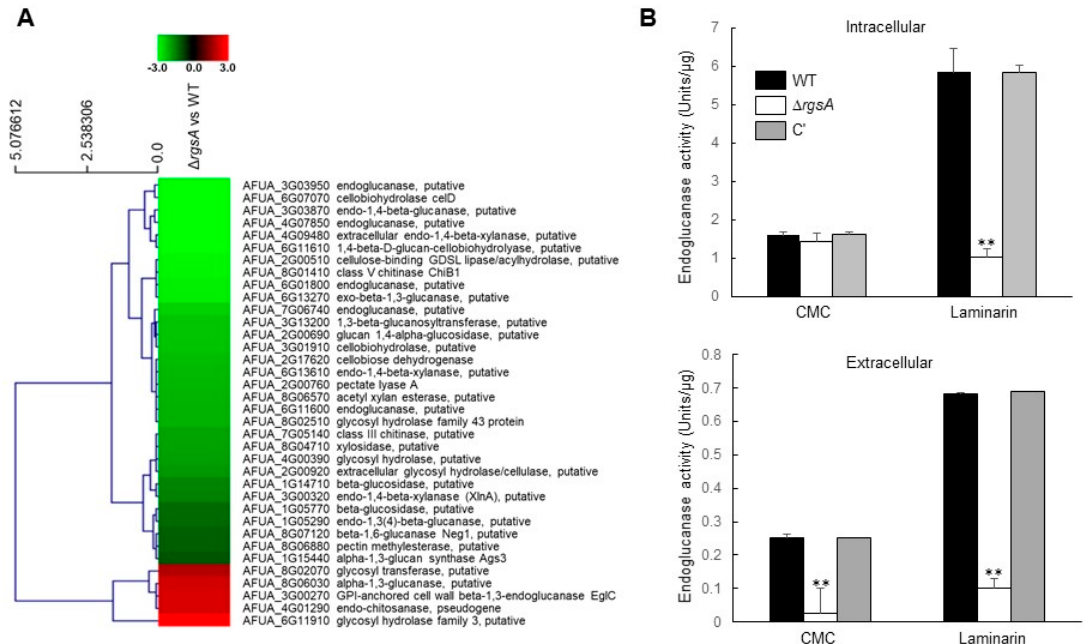
Figure 6. RgsA is needed for proper carbohydrate metabolism. ( A ) Heat map of those genes encoding carbohydrate-metabolism related enzymes. Most of genes were down-regulated by the lack of rgsA . ( B ) Intracellular and extracellular endoglucanase activities of three strains. ANOVA test: ** p < 0.01.